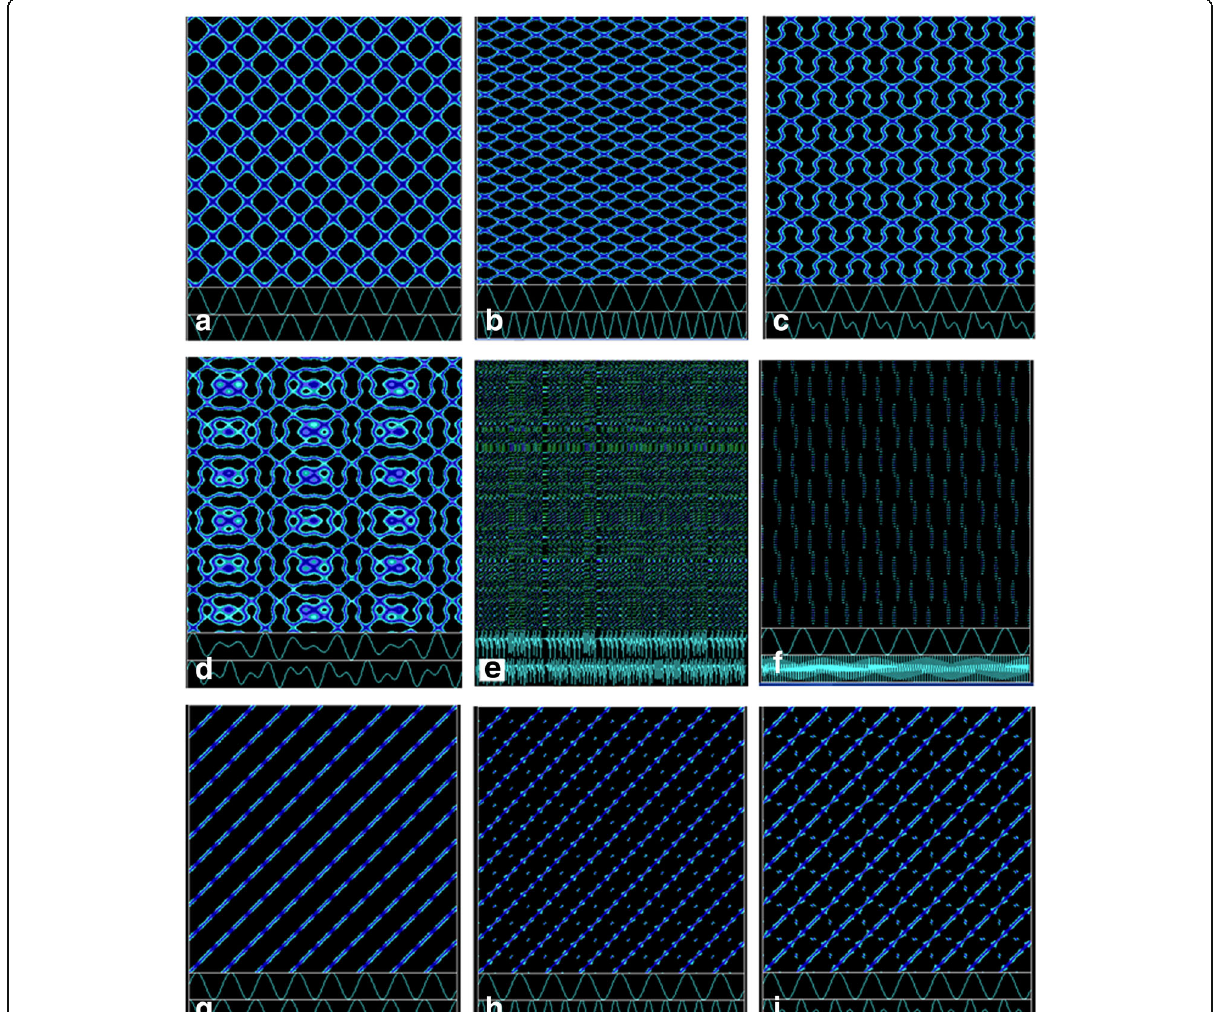
Fig. 4 Cross and joint recurrence plots. a Cross recurrence plot between sin( x ) (upper trace) and cos( x ) (lower trace). High recurrence is represented by the dark blue (straight) lines of synchronisation at 45 o to the horizontal axis. b Cross recurrence plot between sin( x ) (upper trace) and sin(2 x ) (lower trace). High recurrence is represented by the dark blue (straight) lines of synchronisation at tan − 1 (1/2)=26.6° to the horizontal axis. The ratio ½ is the ratio of the frequencies of the two signals. c Cross recurrence plot between sin( x ) (upper trace) and sin( x )+sin(5 x 2 ) (lower trace). High recurrence is represented by the (curved) dark blue lines of synchronisation. The local slope of the line of synchronisation is the arctangent of the ratios of the local ffiffiffi p frequencies of the signals. d Cross recurrence between two quasi-periodic signals: y ¼ sin ð x Þ þ sin ð 2 x Þ (upper frame), y =sin( x )+sin( π x )(lower frame). e Cross recurrence plot between signals from two logistic equations, x n +1 = α x n (1 − x n ), with α =3.7 (upper frame) and α =3.8 (lower frame). The cross recurrence plot is dominated by chaotic transitions (vertical and horizontal lines) but regions of periodic behaviour occur characterised by equally spaced diagonal lines. f Cross recurrence plot for y =sin( x ) (upper frame) and y =sin(20 x ) (lower frame). The large frequency difference between the two signals means that the LOSs are almost vertical. g Joint recurrence plot between sin( x ) (upper trace) and cos( x ) (lower trace). High synchronisation of recurrences is represented by the dark blue regions of synchronisation. h Joint recurrence plot between sin( x ) (upper trace) and sin(2 x ) (lower trace). Lines of high synchronisation between recurrences are represented by the dark blue lines. i Joint recurrence plot between sin( x ) (upper trace) and sin( x )+sin(5 x 2 ) (lower trace). Again high synchronisation of recurrences is represented by the dark blue